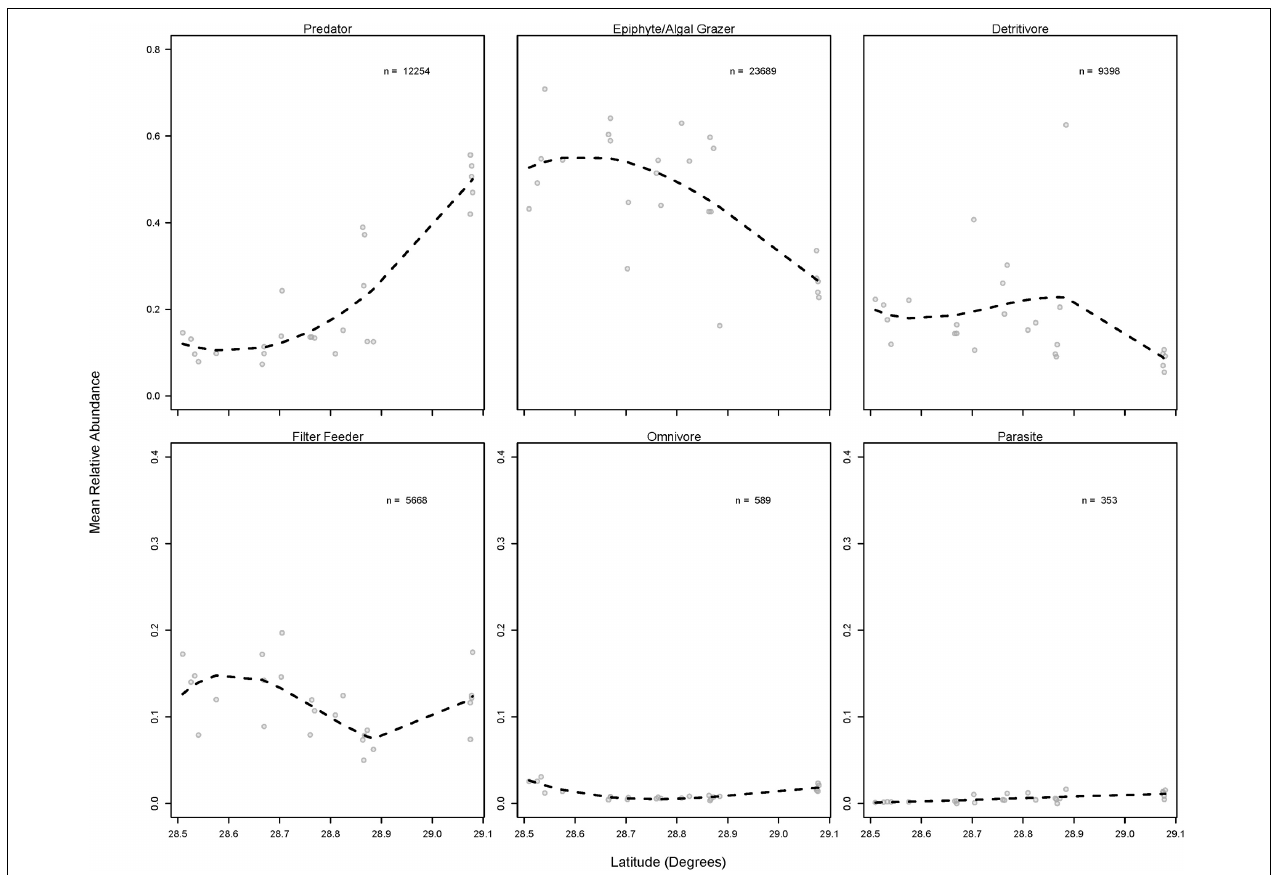
FIGURE 8 | Relative abundance of members of six major trophic roles across latitude. Dashed lines represent the moving average of abundance across latitude. Note the different y -axis scales, “ n ” = the total number of each species found across all samples.